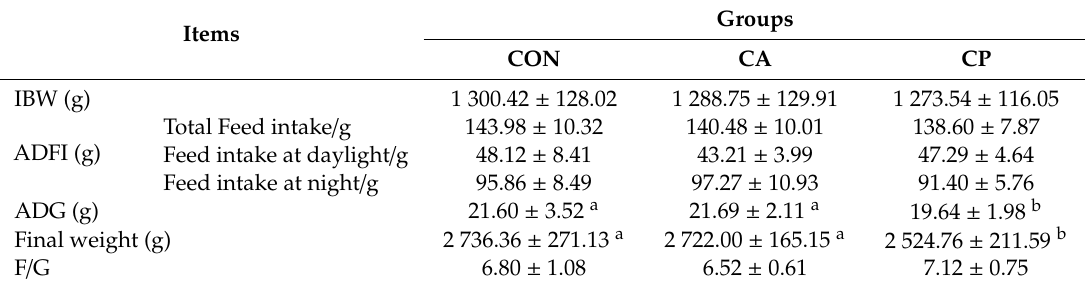
Table 1. E ff ects of wearing a collar and fasting caecotrophy on growth performance of Angora long-haired rabbits.